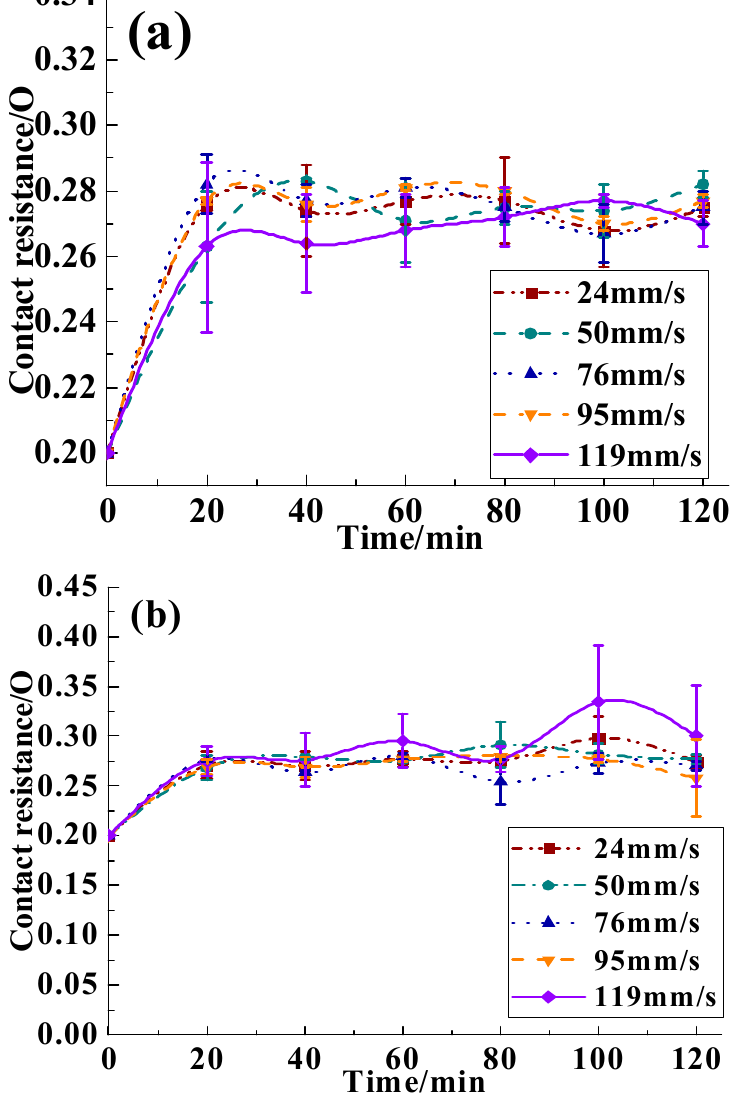
Figure 3. Contact resistance of OLTC couple at different sliding speeds in ( a ) air and ( b ) insulating